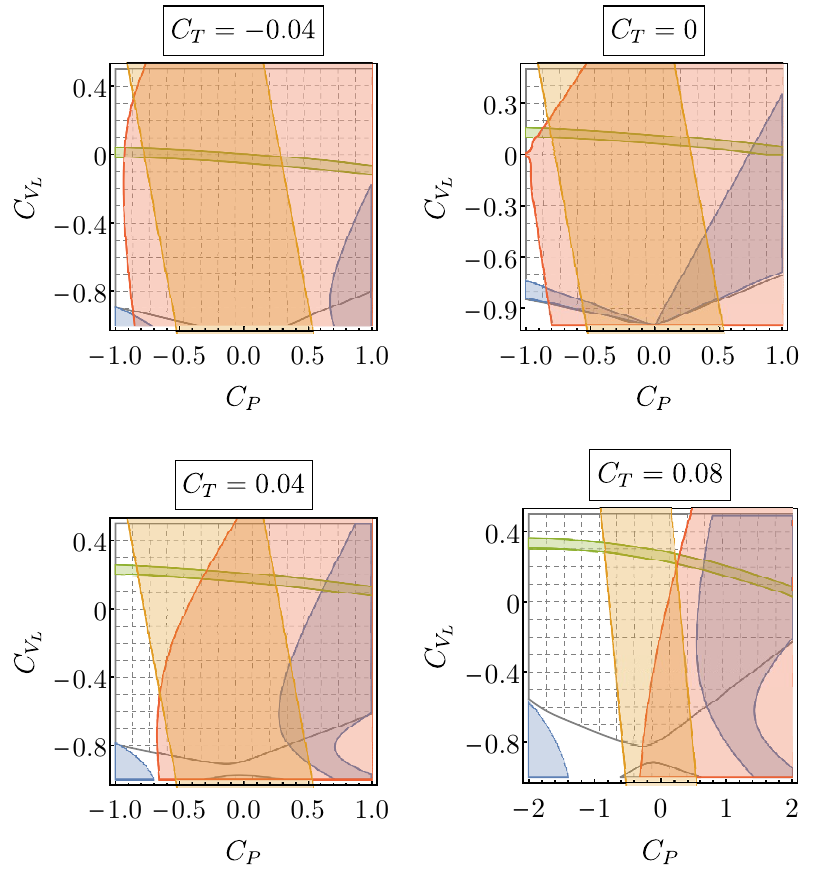
D (cid:3) (blue), (gray grid) and the q 2 (cid:3) (green), (cid:28) L R D P ( B c (cid:28) (cid:22) (cid:23) (cid:28) ) < B !